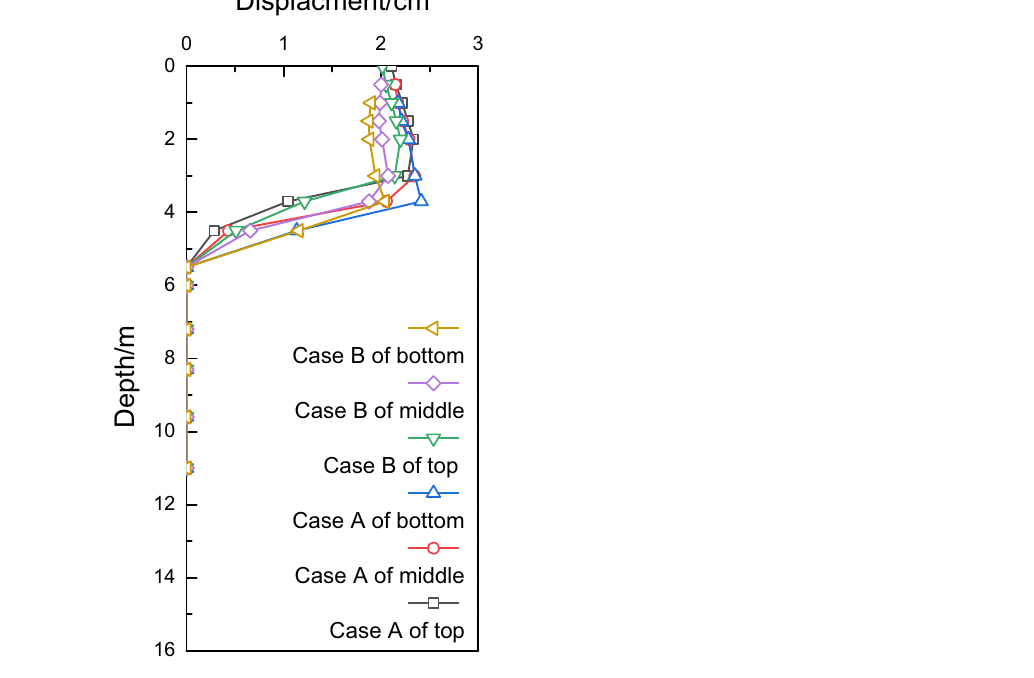
Figure 15. Displacements of the pond